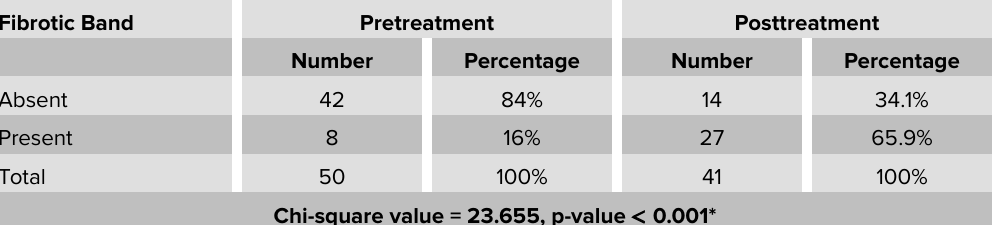
TABLE 6: Frequency distribution of fibrotic band in pre- and posttreatment cases.